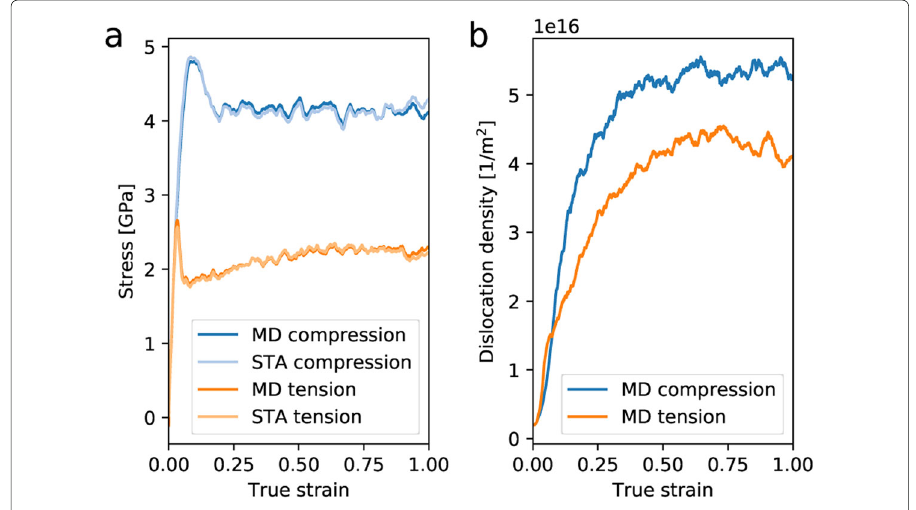
Fig. 4 a Comparison of MD and STA stress-strain curves for bcc Ta strained along the [001] axis in compression and in tension at a strain rate of ˙ ε = 2 × 10 8 /s. The STA stress-strain curves are reconstructed from slip facet data computed using the STA algorithm after which a 3% systematic correction is applied. b Evolution of dislocation densities ρ extracted from DXA snapshots of the same two